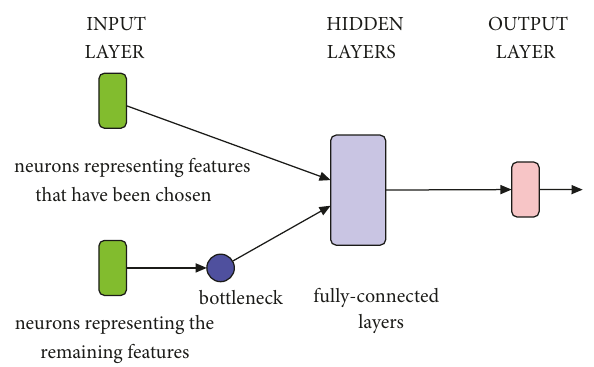
Figure 2: DNN architecture consisting of a bottleneck